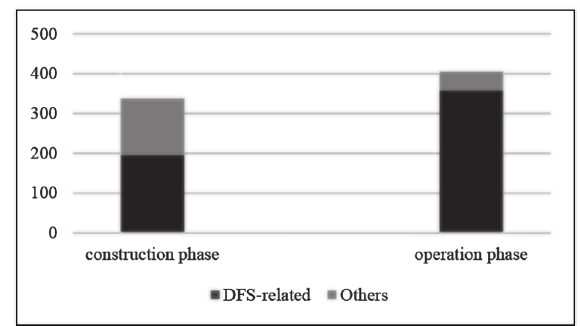
Figure 7. Statistics of incidents by